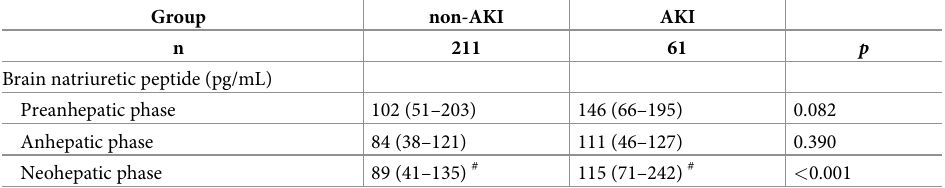
Table 3. Changes in serum levels of brain natriuretic peptide between non-acute kidney injury and acute kidney injury groups during living donor liver transplantation.